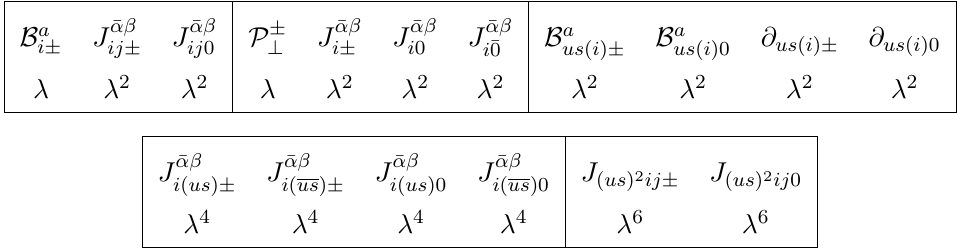
Table 2. Power counting for the complete set of helicity building block operators in SCET I , where the de(cid:12)nitions for these objects are given in eqs. (3.4), (3.6), (3.9), (3.14), (3.17), (3.40), (3.43), (3.44). The building blocks also include the conjugate currents J y in cases where they are distinct from the ones